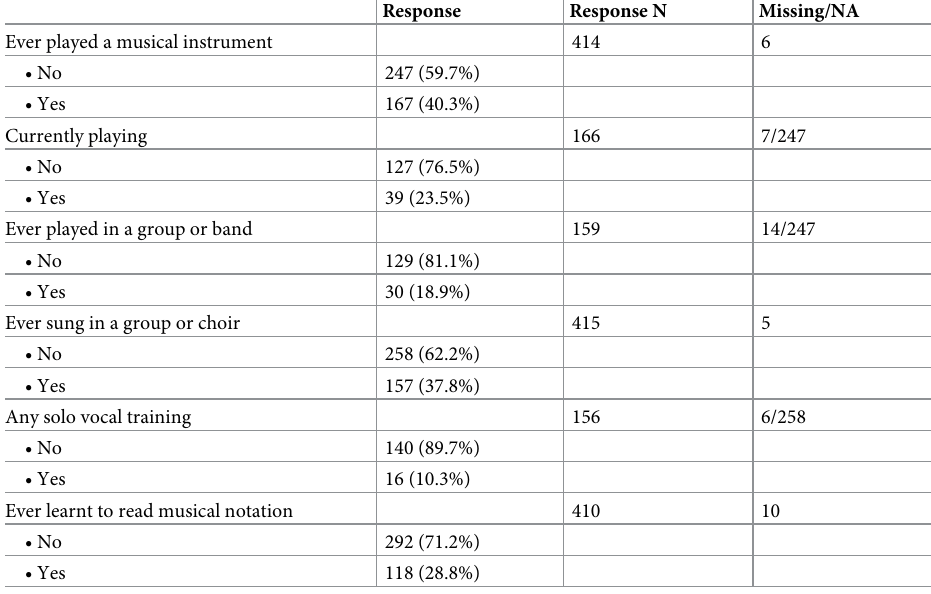
Table 2. Participant responses to the ELMEQ (overall N =